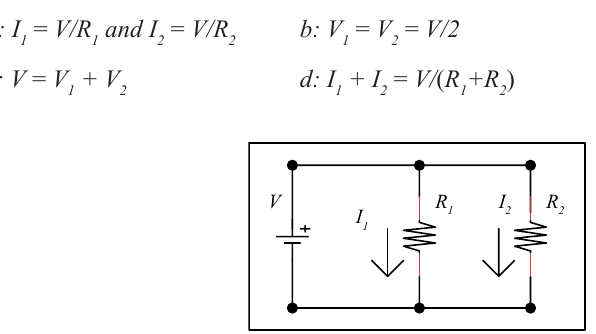
Fig. A2. The current and the voltage in a simple electric dc